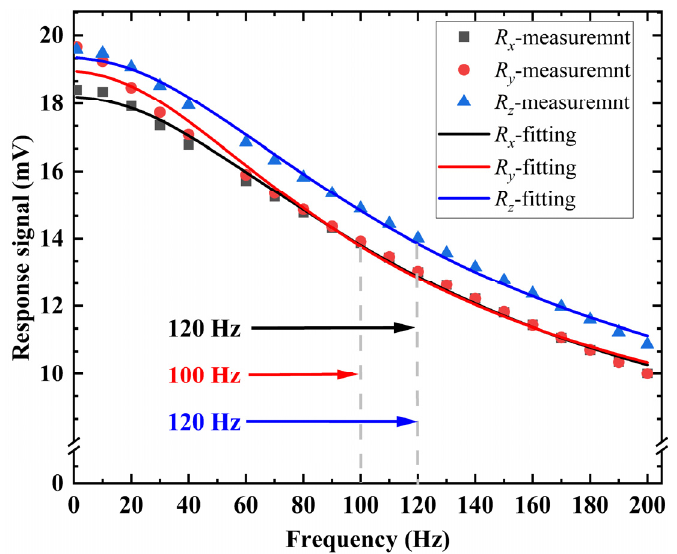
Figure 6. The three-channel frequency response signal and the fitting curves. The bandwidths were 120Hz, 100 Hz, and 120 Hz in x -, y -, and z -channel, respectively. According to the fitting results, the bandwidths were 120 Hz, 100 Hz, and 120 Hz in x -, y -, and z -channel,